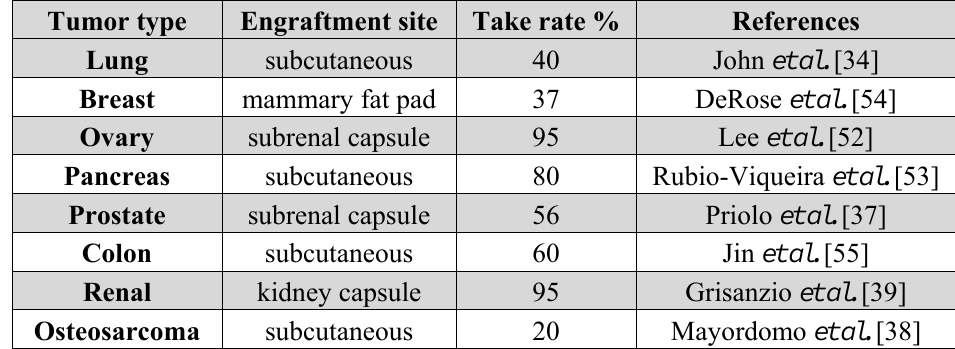
Supplementary Table 2. Summary of various patient derived tumor models showing engraftment rate (%) and site of tumor growth.